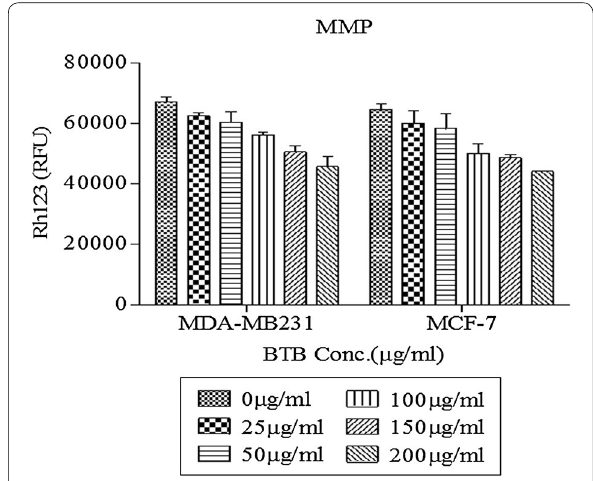
Fig. 5 Mitochondrial membrane potential analysis by Rhodamine123 Staining: the values indicate the Rhodamine-123 fluorescence intensity in cells treated with a range of concentrations (0–200 µg/ml) for 24 h. The graph is illustrating the increased cell permeability and loss of mitochondrial membrane potential as compare to untreated